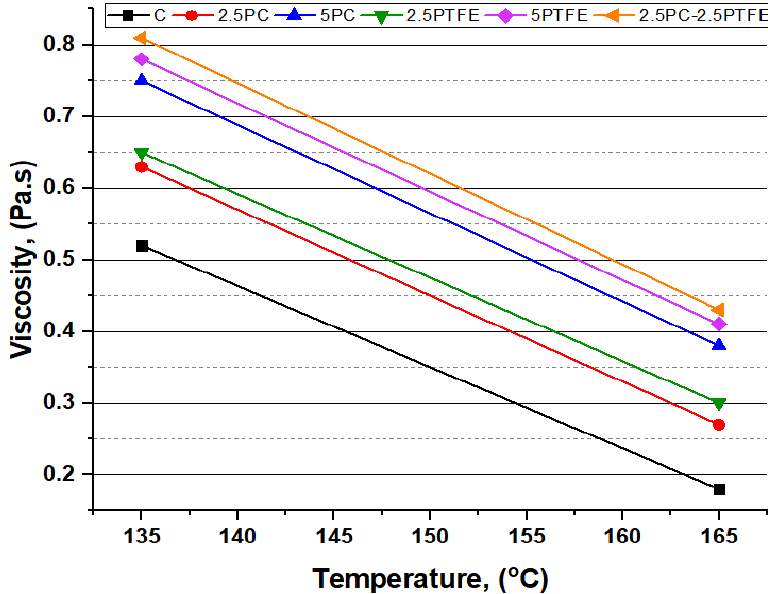
Figure 11. Temperature – viscosity relationship of binders.